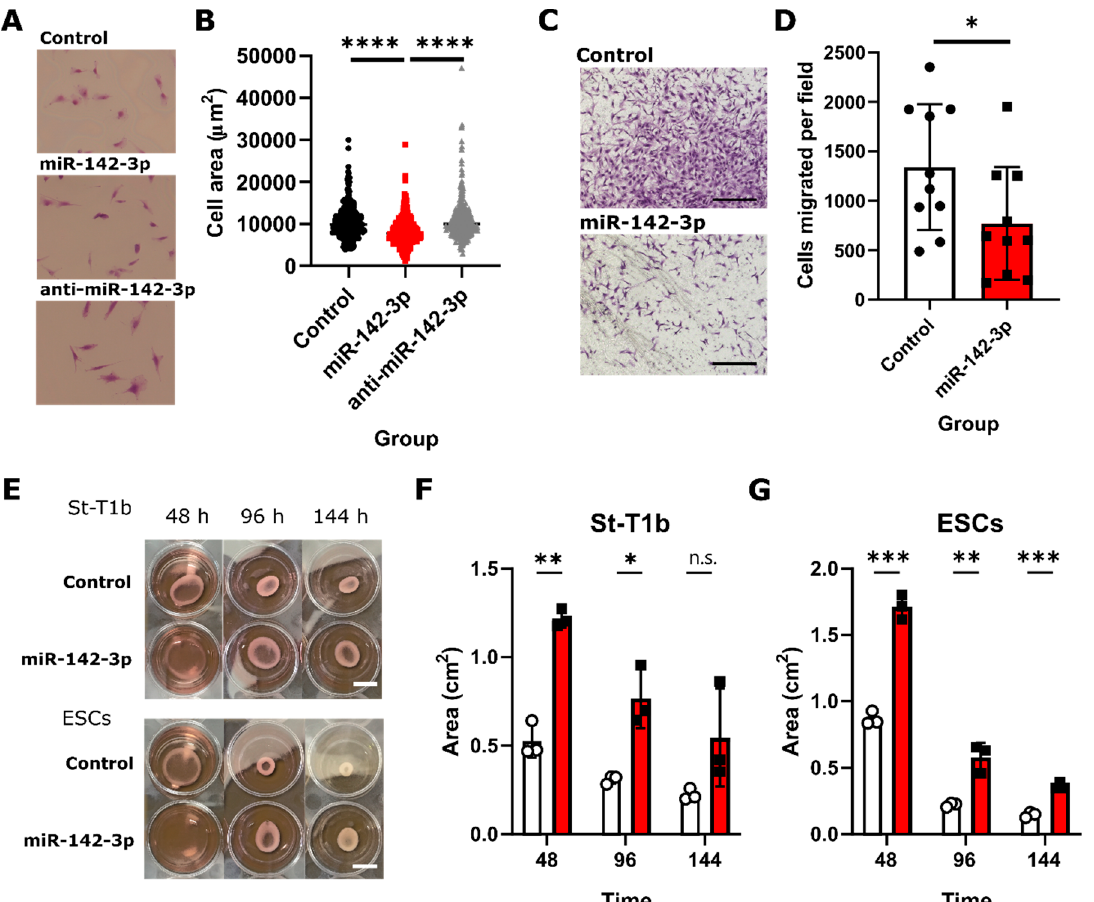
Figure 4. miR-142-3p affects cell size, invasion and contractility in St-T1b cells. ( A ) MiR-142-3p reduces stromal cell size, 320-fold magnification. ( B ) Quantification of the effect of miR-142-3p on stromal cell size ( n = 376, Kruskal-Wallis test). ( C ) Migration assay through fibronectin (an ITGAV ligand)-coated chamber. Scale bar, 250 µm. ( D ) MiR-142-3p reduces the migratory potential of stromal cells ( n = 10, t -test). ( E ) Collagen contraction assay after 48, 96, and 144 h in St-T1b and ectopic stromal cells (ESCs), Scale bar, ~5 mm. ( F , G ) MiR-142-3p reduces contractility of both eutopic St-T1b and ectopic ESCs cells ( n = 3, multiple t -tests, data are representative of two independent repeats). Data in the whole figure panel represent mean ± s.d. For all figures in this panel * p < 0.05; ** p < 0.01; *** p < 0.001, **** p < 0.0001, and n.s. p > 0.05.